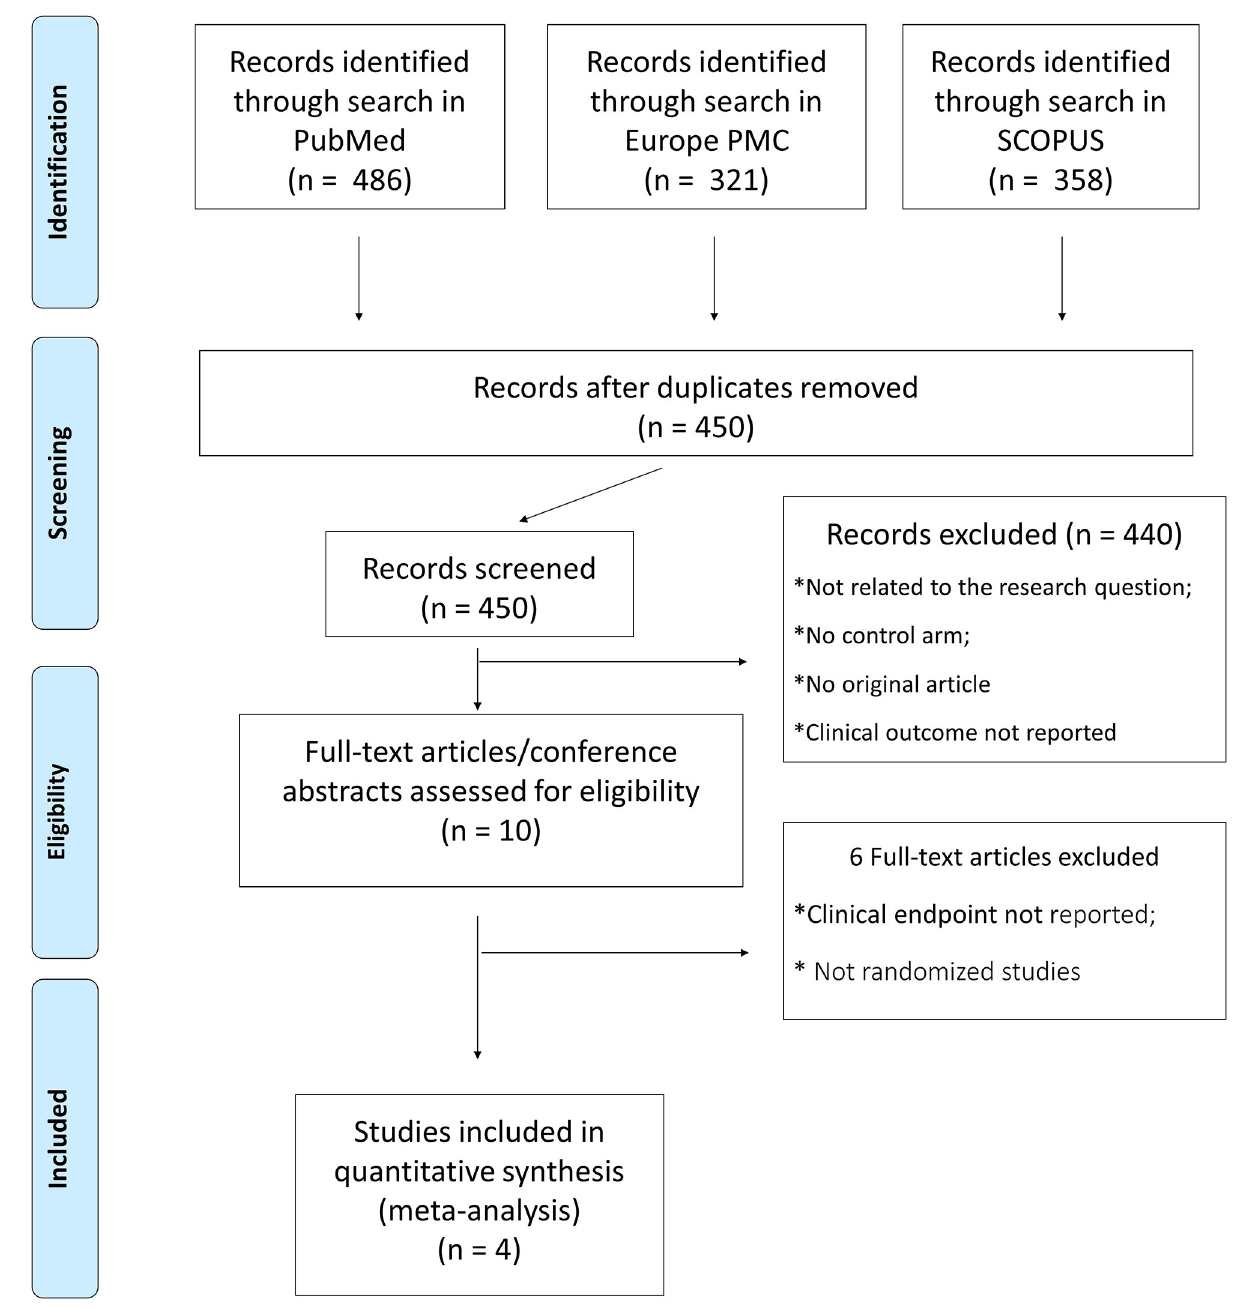
Fig 1. Study selection